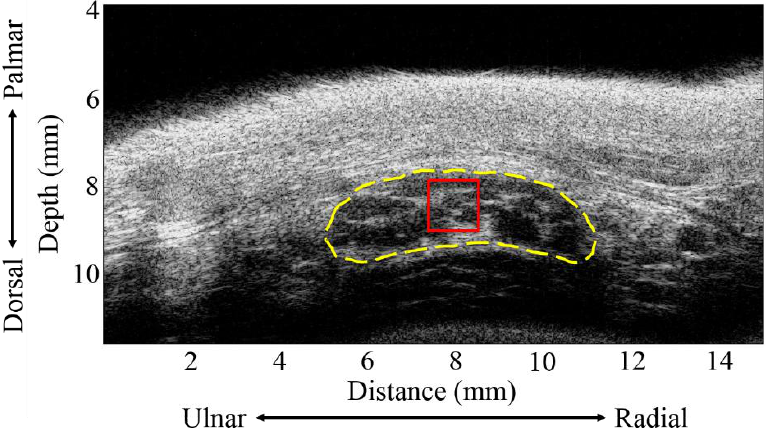
Figure 3. B-mode images of the MN. The yellow contour drawn manually corresponds to the MN. The red rectangle indicates region of interest for motion